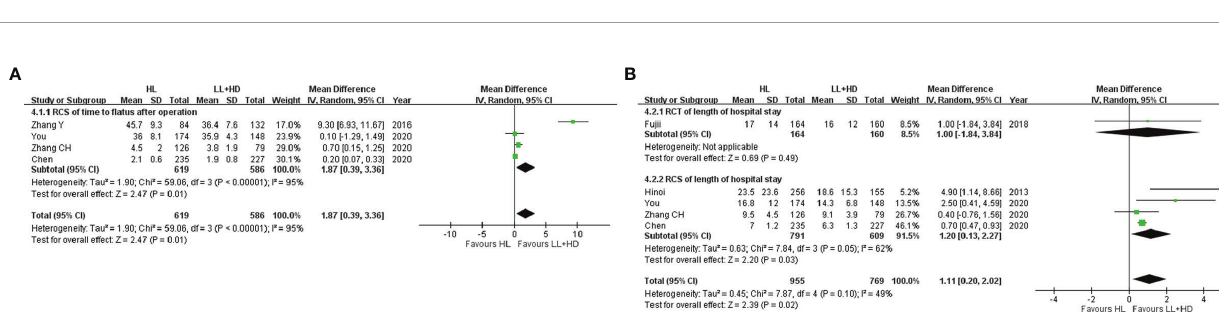
FIGURE 4 | Meta-analysis of postoperative recovery. (A) Forest plot ofbowelfunction recovery following HLversusLL+HD. (B) Forest plotof the length of hospital stay following HLversusLL+HD. HL, high ligation of theinferior mesentericartery; LL+HD, low ligation of the inferior mesentericarteryplushighdissection of lymph